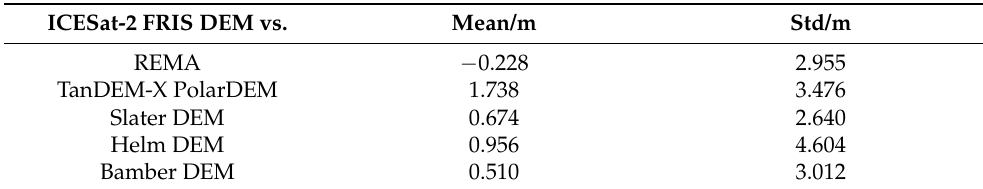
Table 5. Comparisons between the ICESat-2 FRIS DEM and five previously published Antarctic DEMs. ICESat-2 FRIS DEM vs.